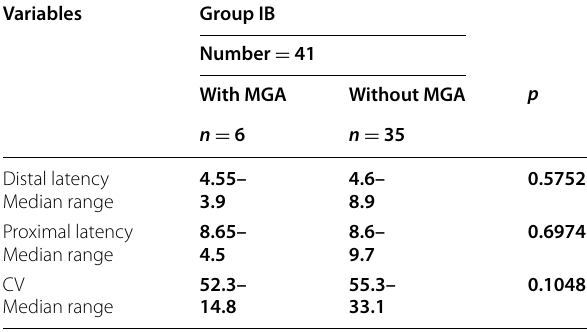
Table 4 Comparisons among CTS patients (group IB) with and without MGA regarding their electrophysiological